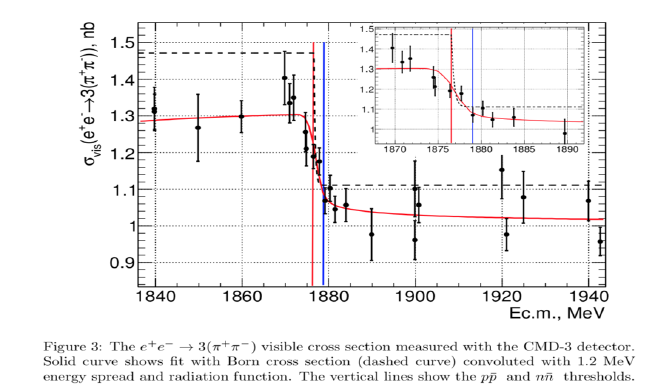
Figure 7: Cross section of e + e − → 3 ( π + π − ) process measured by CMD-3 [ 25 ] . The solid line is a fit with empirical function. The vertical lines indicate the p ¯ p and n ¯ n thresholds.